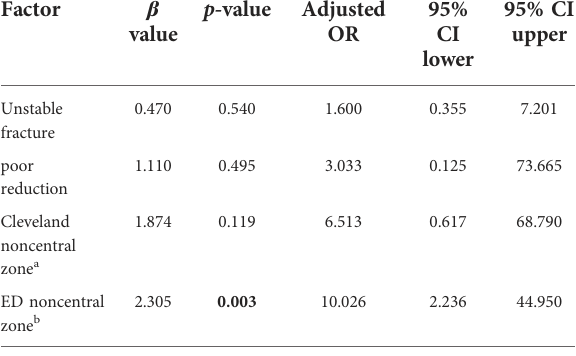
TABLE 2 Multivariate logistic regression analysis.